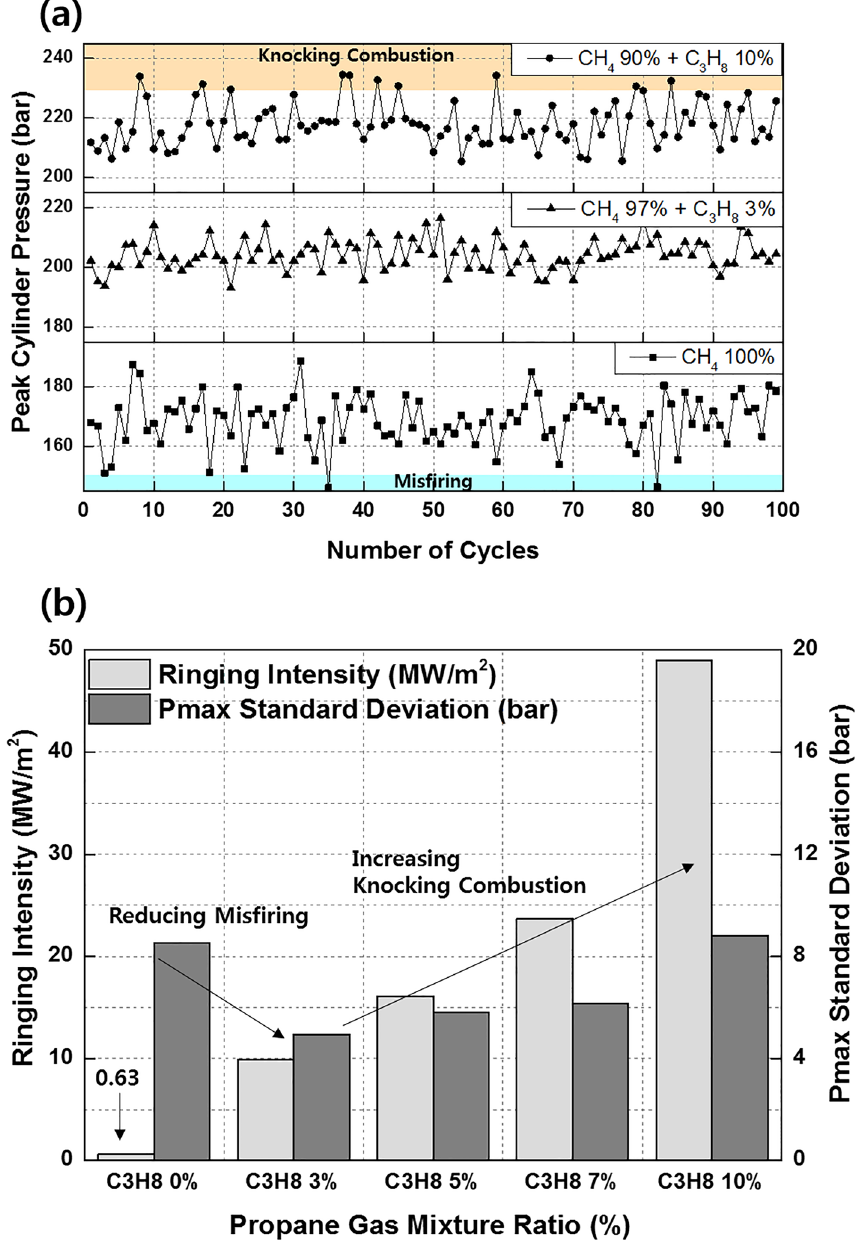
Figure 12. Effects of the C 3 H 8 mixture ratio on the ( a ) cycle to cycle variation in the peak cylinder pressure and ( b ) RI and STD of the peak cylinder